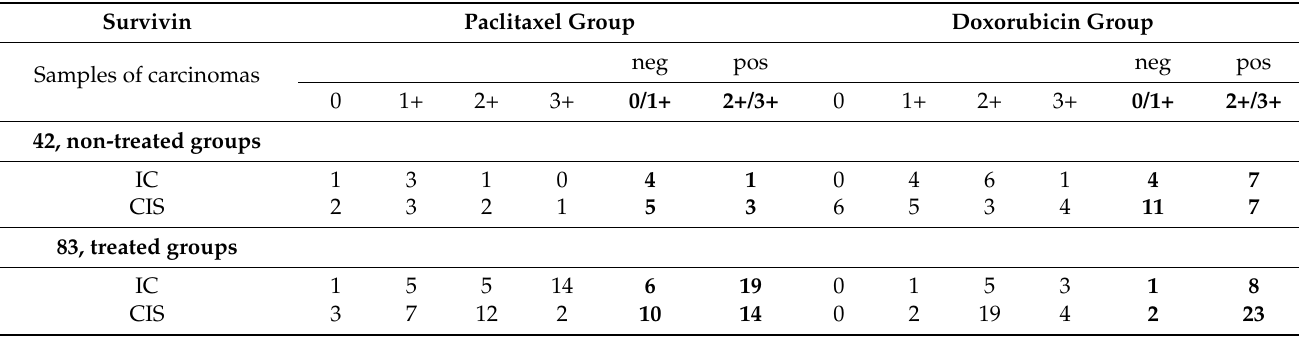
Table 3. Expression of survivin in invasive carcinoma (IC) and carcinoma in situ (CIS) tumor samples from non-treated and treated groups of female rats.